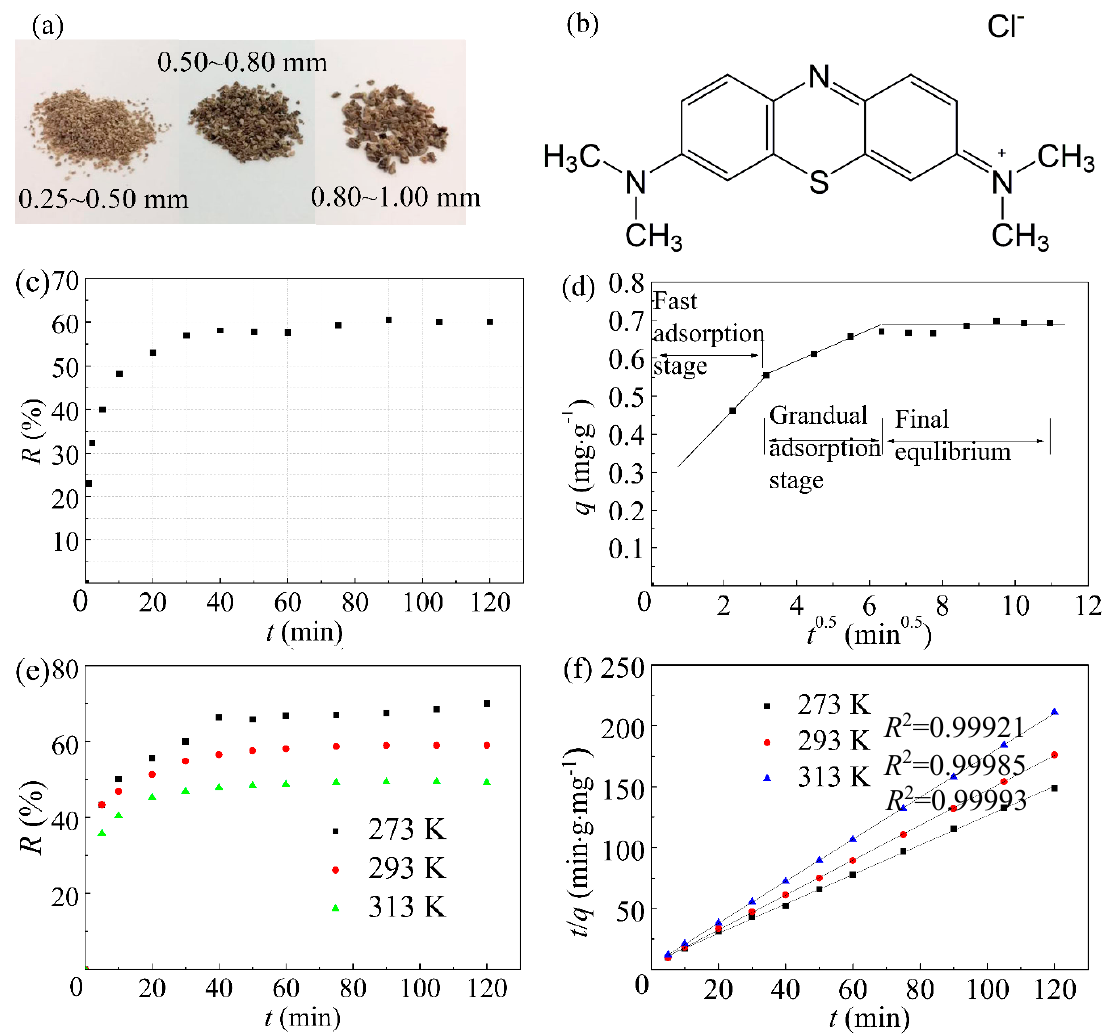
Figure 2. ( a ) Photograph of bone char with different sizes, ( b ) chemical structure of methylene blue, ( c ) effect of contact time on the removal rate of methylene blue (bone char particle size: 0.5~0.8 mm; T : 303 K), ( d ) three stages of the removal process of methylene blue by bone char represented by three continuous tend lines, ( e ) effect of adsorption temperature on the adsorption, and ( f ) pseudo-second-order kinetic model of the adsorption process (bone char particle size: 0.50~0.80 mm).